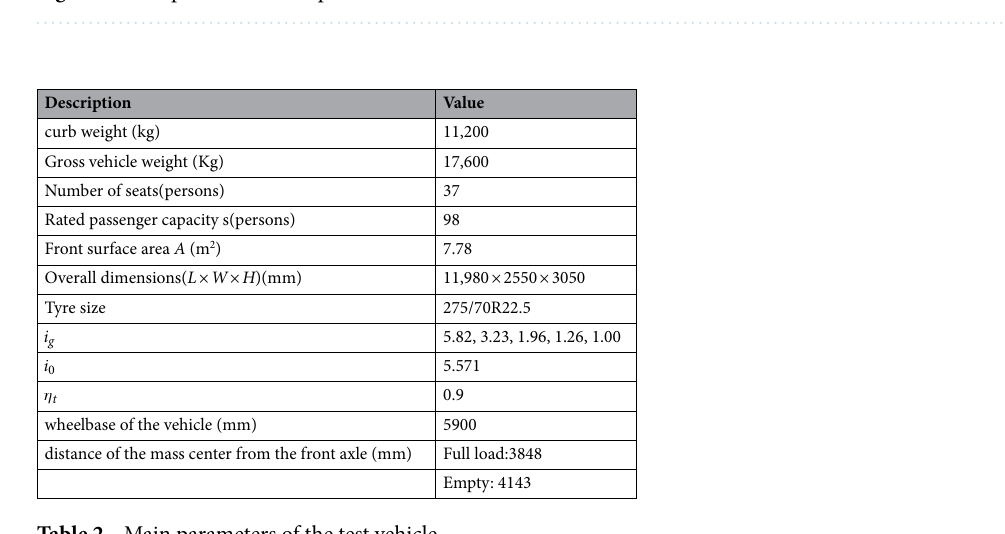
Figure 3. The performance map for WP7.270.